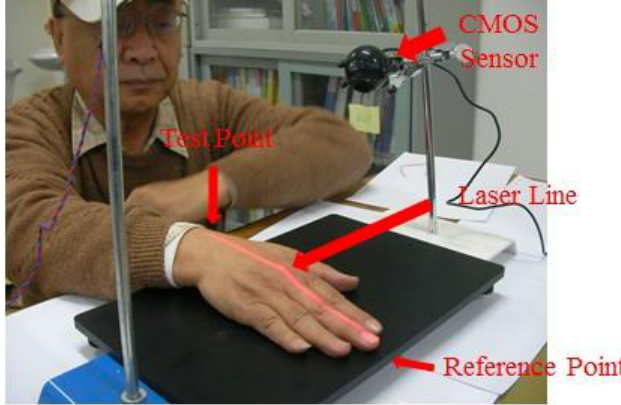
Figure 12. Frequency vibration detection carried out with the hand in a resting state.